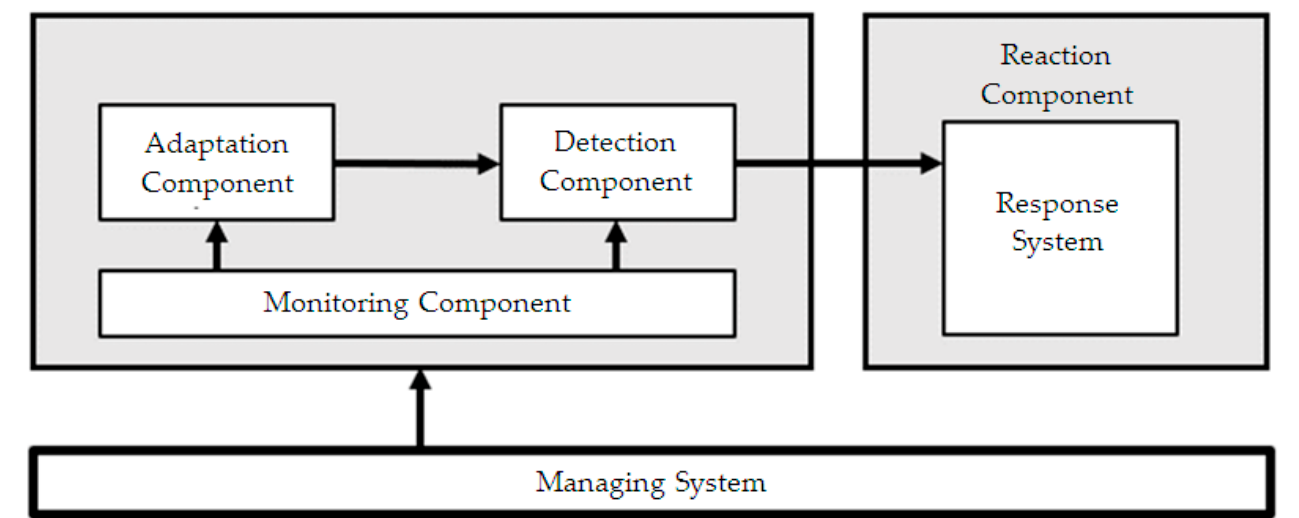
Figure 1. Intrusion response system: an extended generic view.